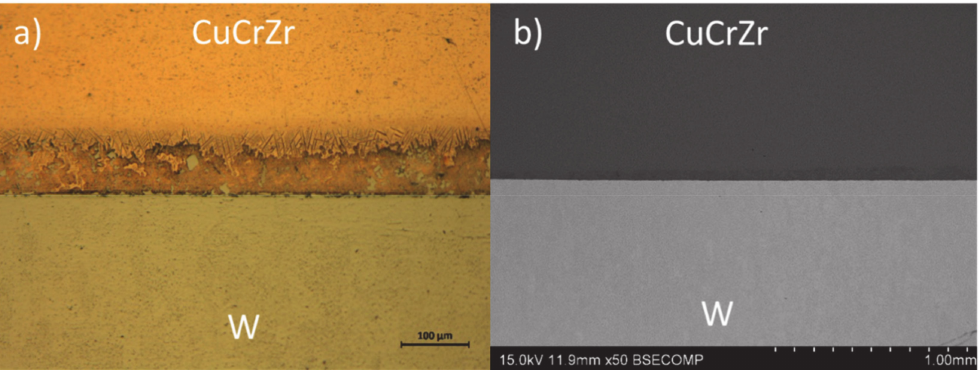
Figure 2. General micrographs of the W-CuCrZr joint brazed with Cu-20Ti filler obtained by ( a ) Optical Microscopy and ( b )